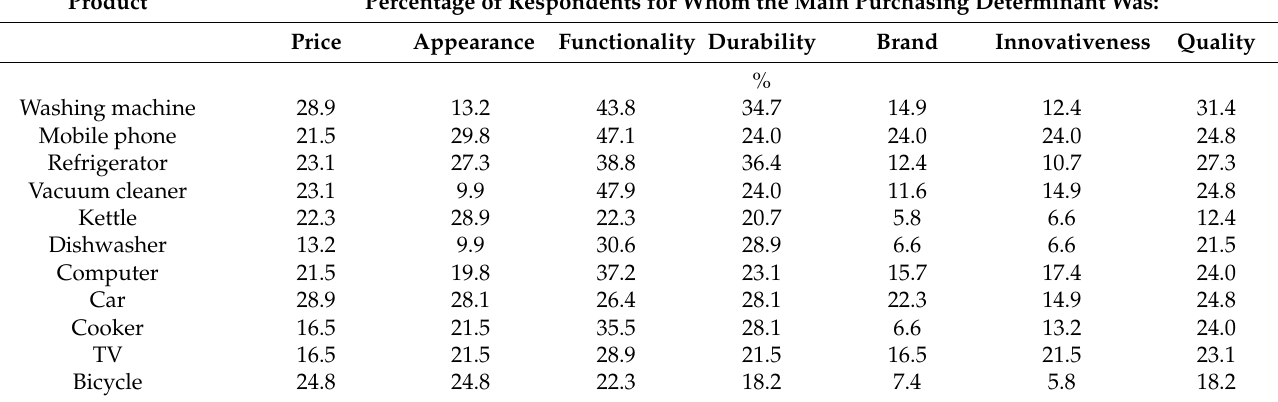
Table 2. Main determinants of purchases of selected durable products.